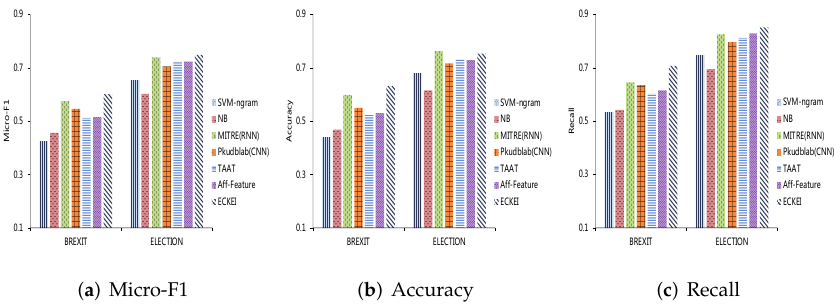
Figure 8. Micro-F1, accuracy and recall results on two datasets for the neutral stance.